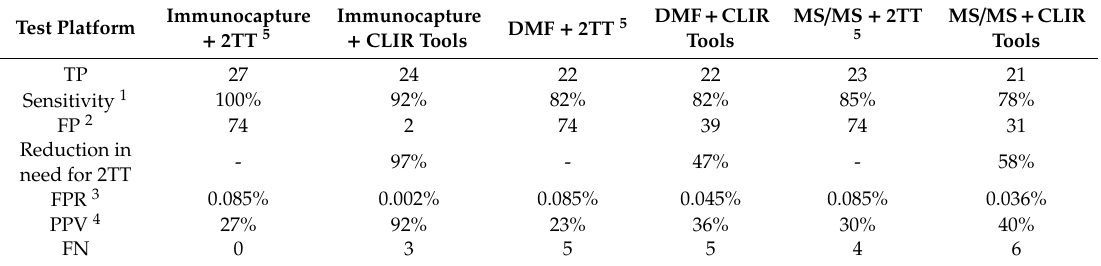
1 Sensitivity calculated as true positive cases / (true positive cases + false negative cases) [TP / (TP + FN)]; 2 FP, false positive cases based on the first DBS sample, includes non-carriers, carriers, and cases with genotypes leading to pseudodeficient enzyme activity. 3 FPR, false positive rate calculated as false positive cases / (false positive cases + true negative cases) [FP / (FP + TN)]. 4 PPV, positive predictive value calculated as TP / (TP + FP). 5 2TT, 2nd